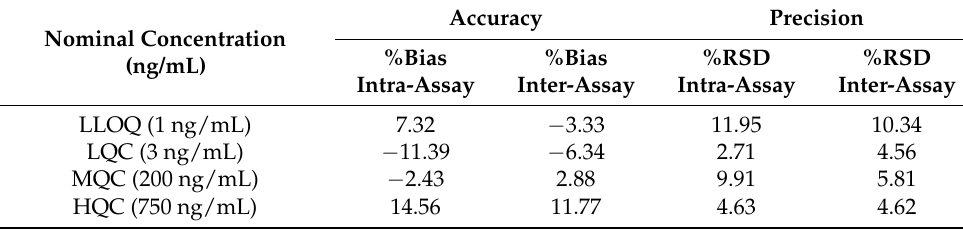
Table 2. Intra and inter-assay accuracy and precision of ICG in rat plasma ( n =